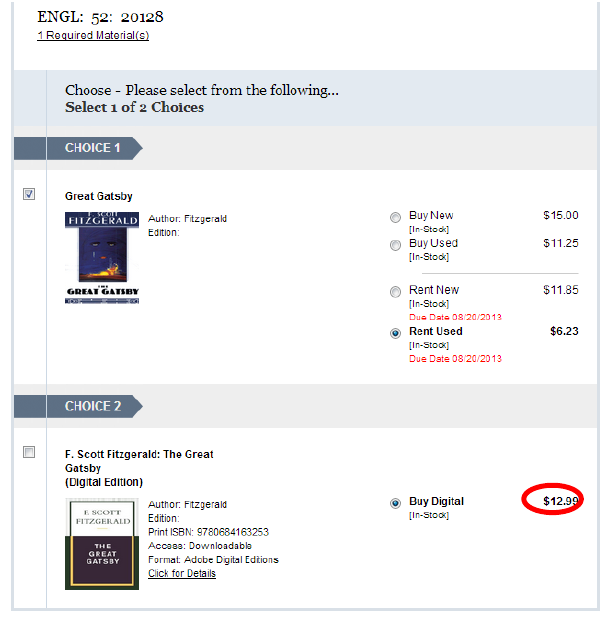
Figure 2 . Example 1 for finding an average section textbook cost.